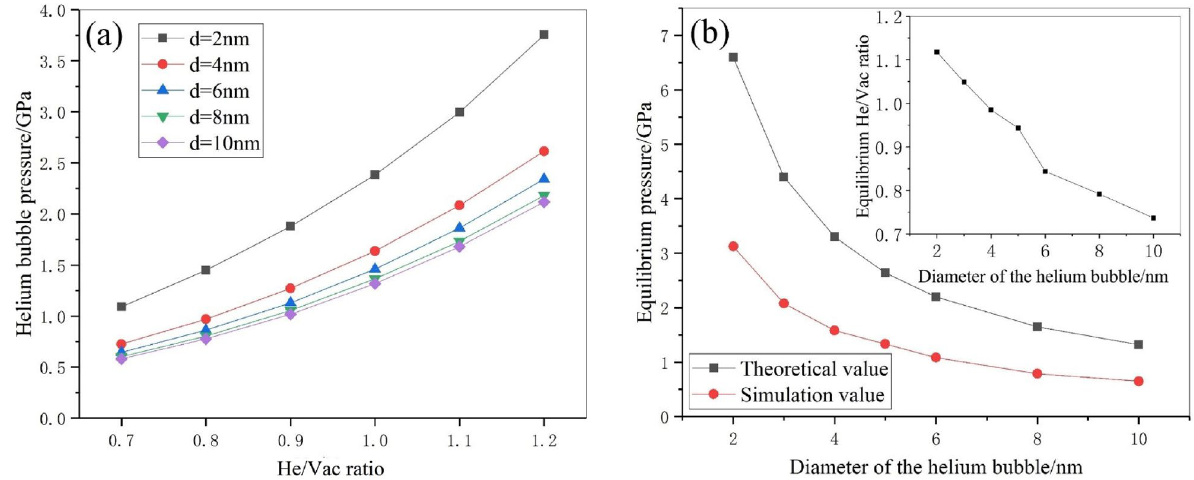
Figure 4. ( a ) Helium bubble pressure with respect to He/Vac ratio regarding different bubble sizes. ( b ) Equilibrium pressure and equilibrium He/Vac ratio with respect to the size of helium bubble.